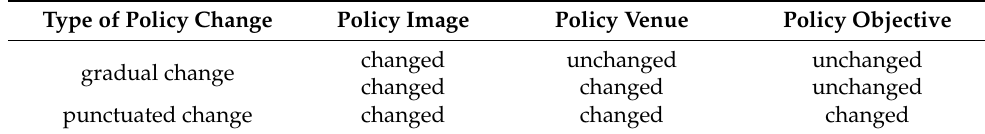
Table 1. The criteria to identify the type of policy change. Type of Policy Change Policy Image Policy